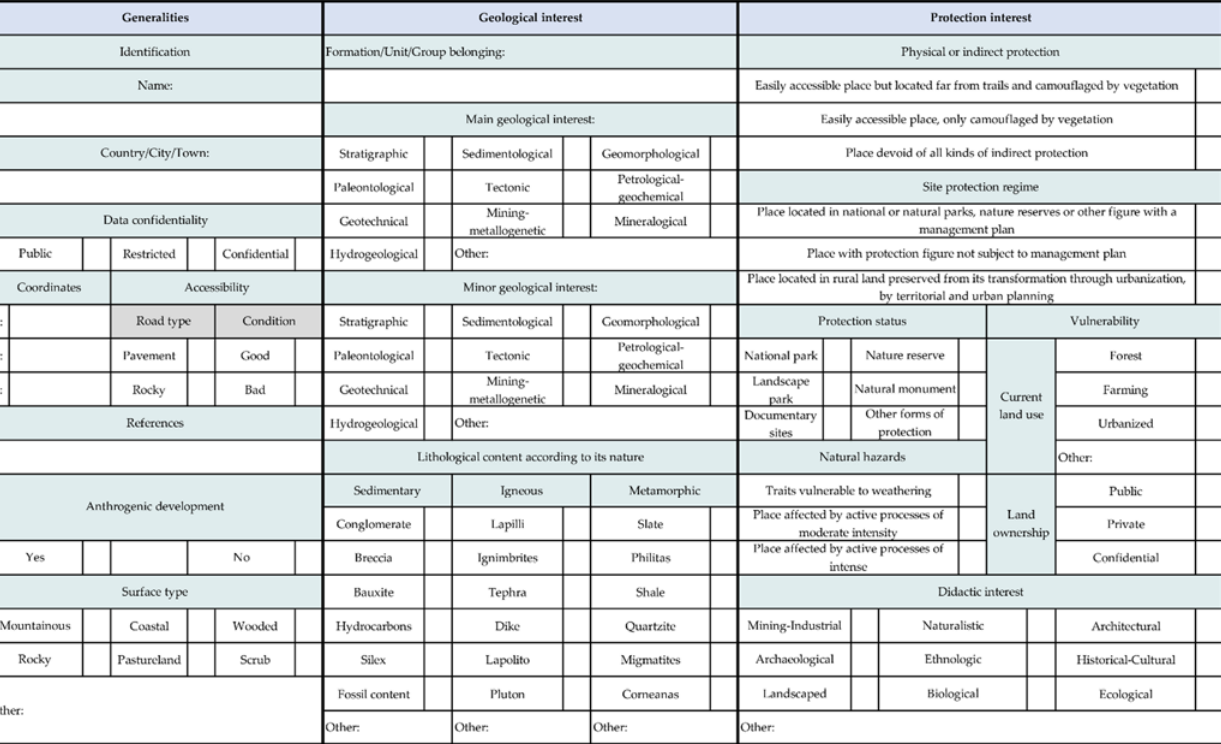
Figure 3. The general sheet used to identify sites of geological interest.